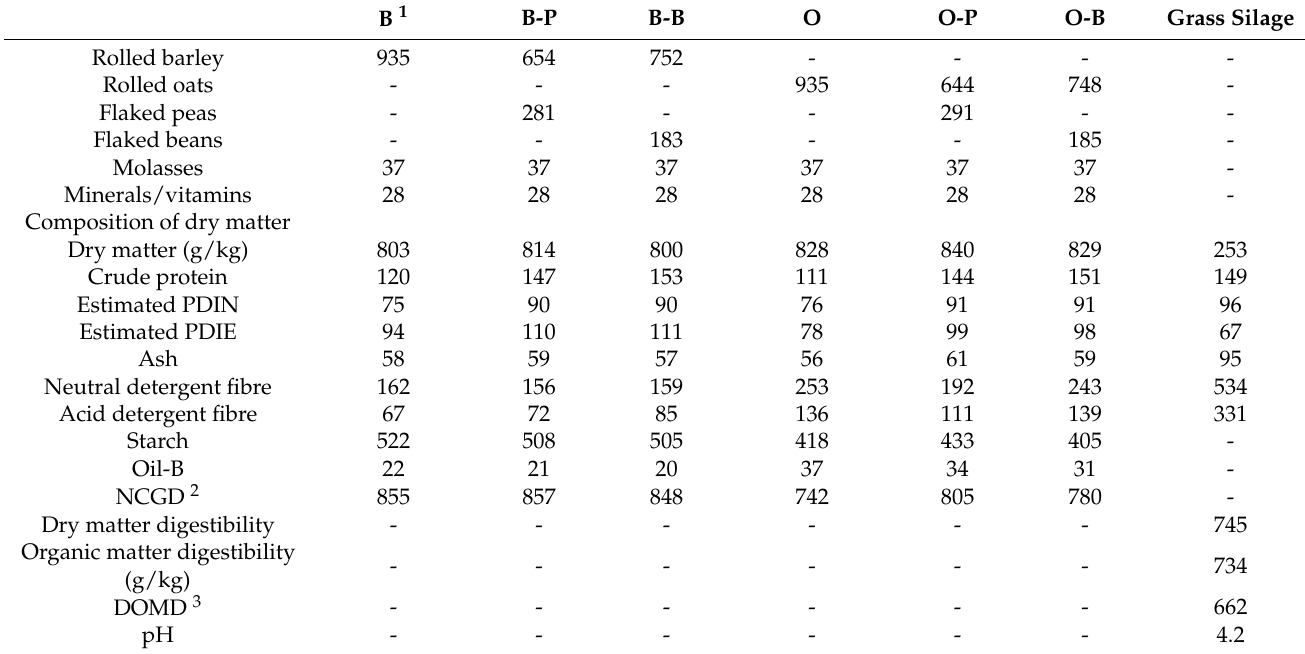
Table 3. Ration composition (g/kg DM), dry matter, chemical composition and in vitro digestibility (g/kg DM unless otherwise stated) of the perennial ryegrass-dominant grass silage and experimental concentrate rations used in Experiment